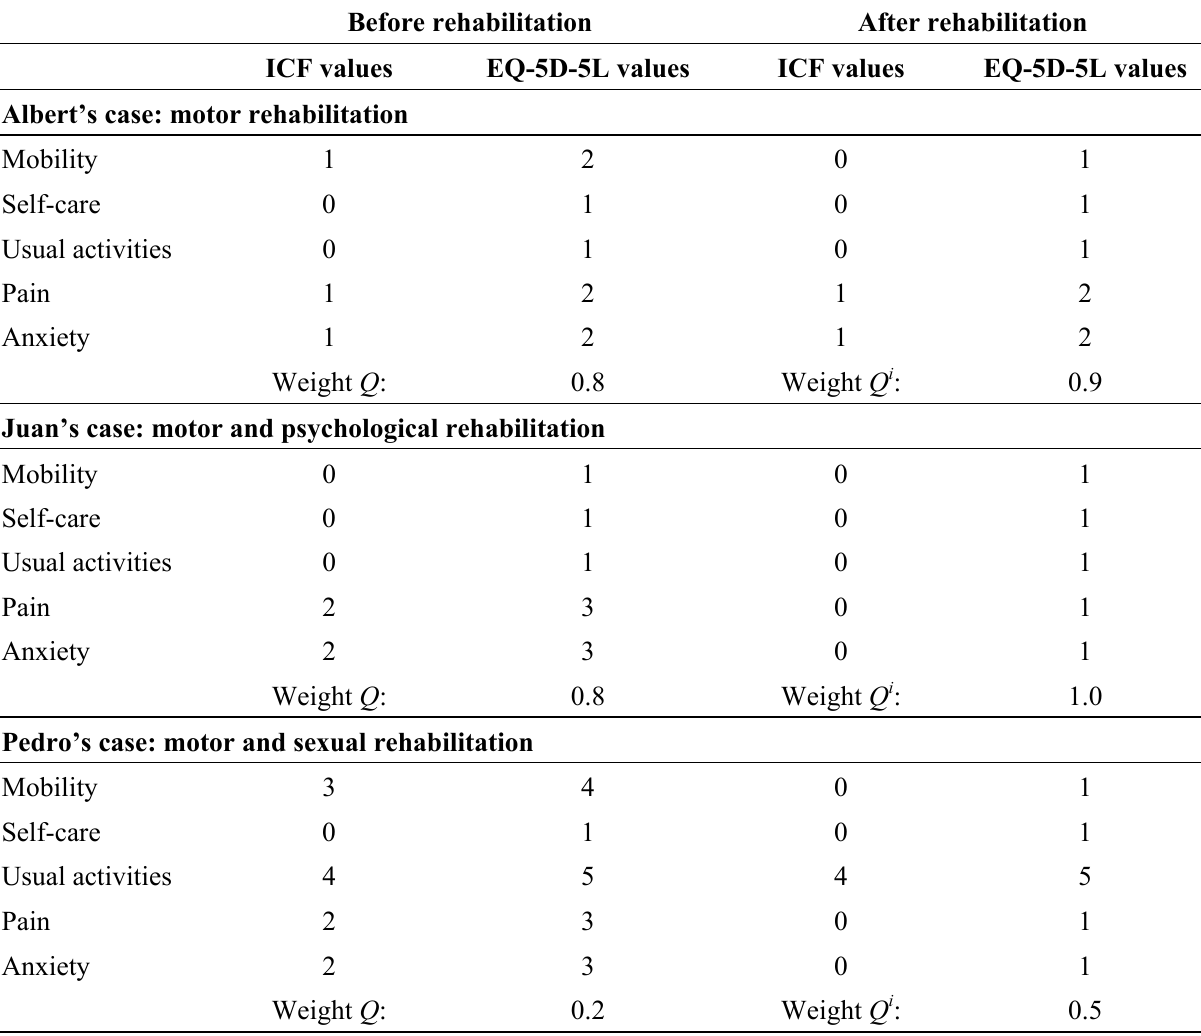
Table 7. Mapping of ICF values into health status weights Q and Q i